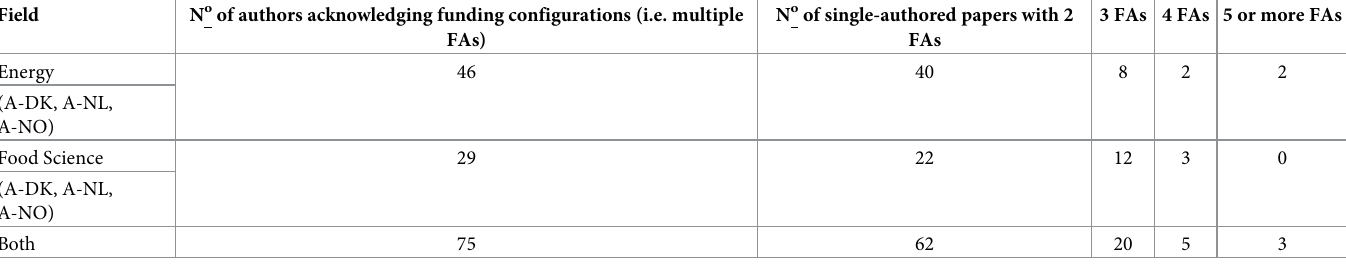
Table 5. Funding configuration patterns in the two fields by number of FAs, 2009–18.